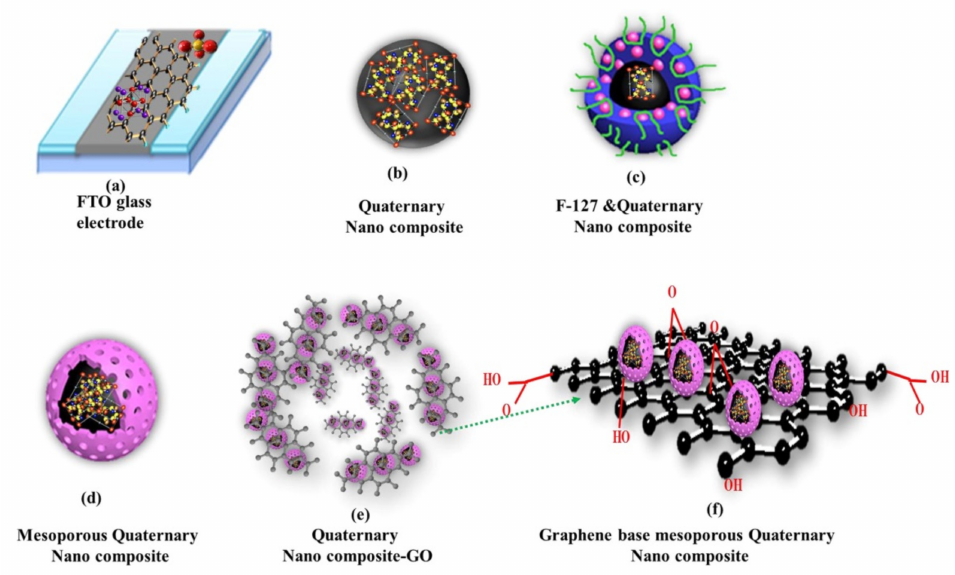
Figure 3. Schematic presentation of the synthesis process of the ZrO 2 -Ag-Graphene Oxide -SiO 2 nanocomposite. Adapted with permission from [46] Copyright 2020, American Chemical Society.